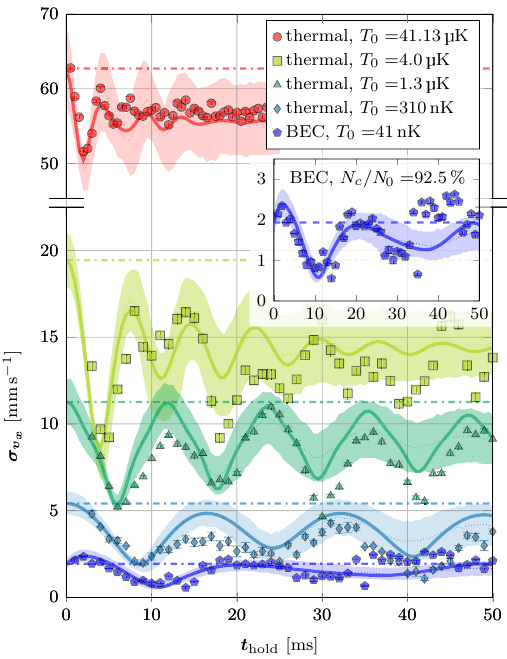
Fig. 2 Oscillations of expansion velocity. Expansion velocity ( σ v ) after 30 ms of time of fl ight in dependence of the holding time. The graph shows the expansion velocity for thermal ensembles with different initial temperatures T 0 and the Bose-Einstein condensate (BEC) with an initial expansion temperature of T 0 = 41 nK and a condensed fraction of N c / N = 92.5%. The markers show the measurements, the dashed-dotted lines 0 the expansion rate from the initial traps (cf. black dashed-dotted line in Fig. 1). The simulations use the scaling ansatz and are depicted as lines with a shaded 1-sigma error estimation for the used trap parameters. The inset displays the size oscillation of the Bose-Einstein condensate on an enlarged scale for better